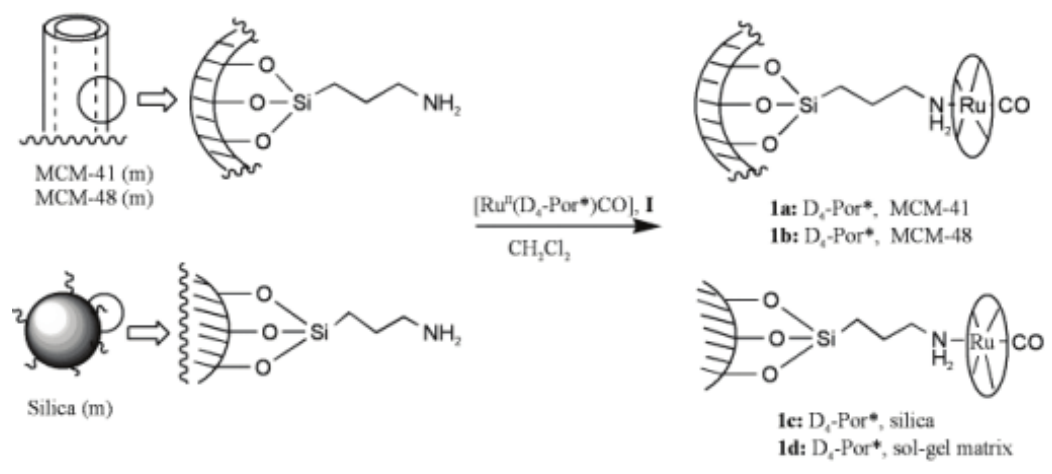
(D -Por*) onto MCM-41 and MCM-48 (top) and silica surfaces (bottom) [77]. Reprinted with permission from Figure 5: Immobilisation of H 2 4 Ref. [77]. Copyright © 2002, Royal Society of